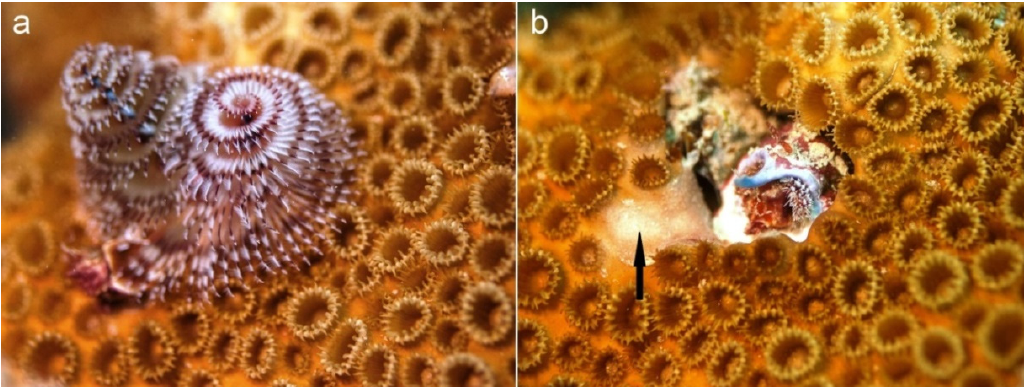
Figure 3. Palythoa caribaeorum acting as a secondary host for Spirobranchus giganteus at 5 m depth, Cayo Media Luna (La Parguera Natural Reserve), Puerto Rico, Greater Antilles (2017): ( a ) worm extended and ( b ) retracted, showing the tube opening surrounded by dead coral; damage to the zoantharian host caused by the operculum of the extended worm indicated by a black arrow.